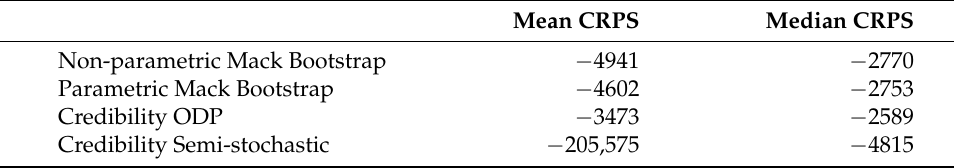
Table A1. Mean and median CRPS values if the underlying model is log-normal.